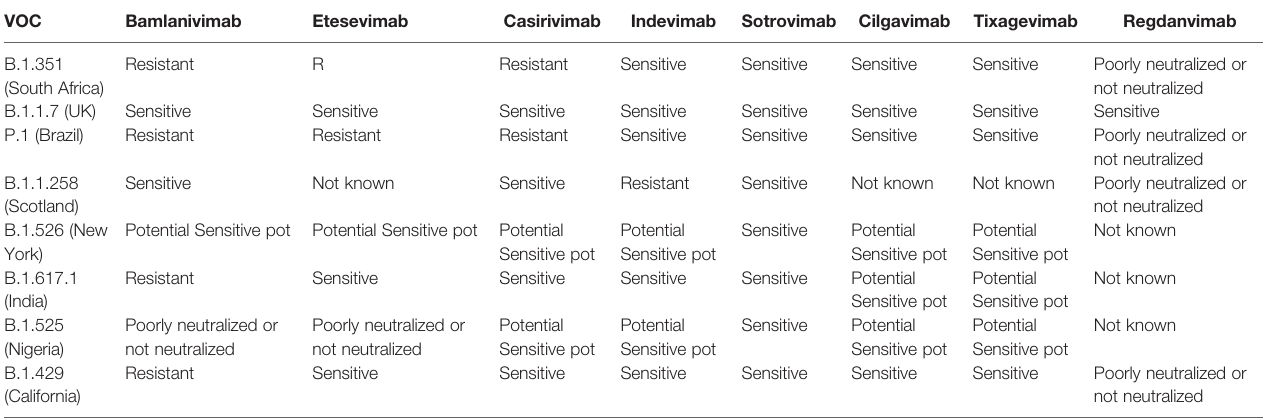
TABLE 7 | Mutations of SARS-CoV-2 S in VOC and resistance pro fi le of clinical mAbs.